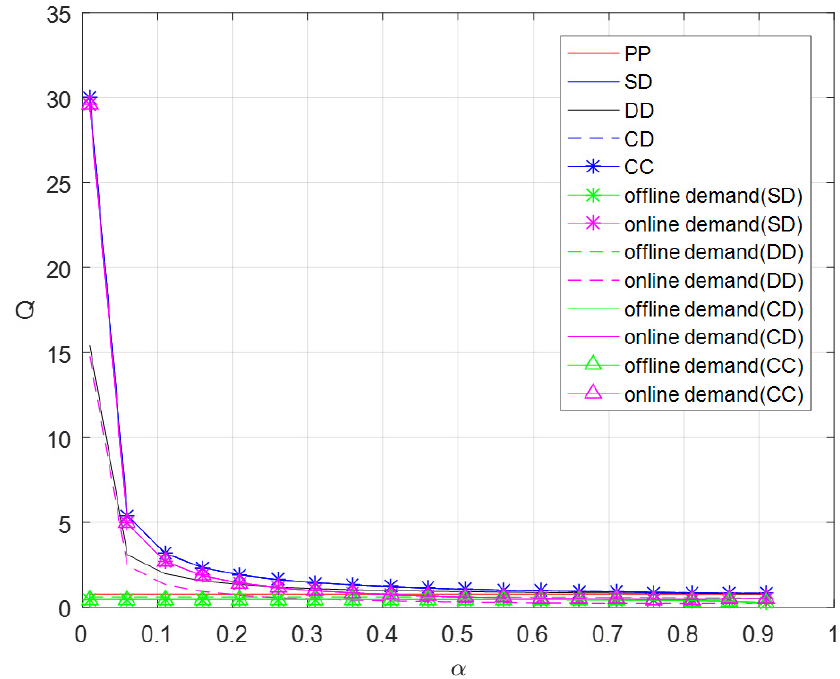
Figure 4. Optimal demand versus α